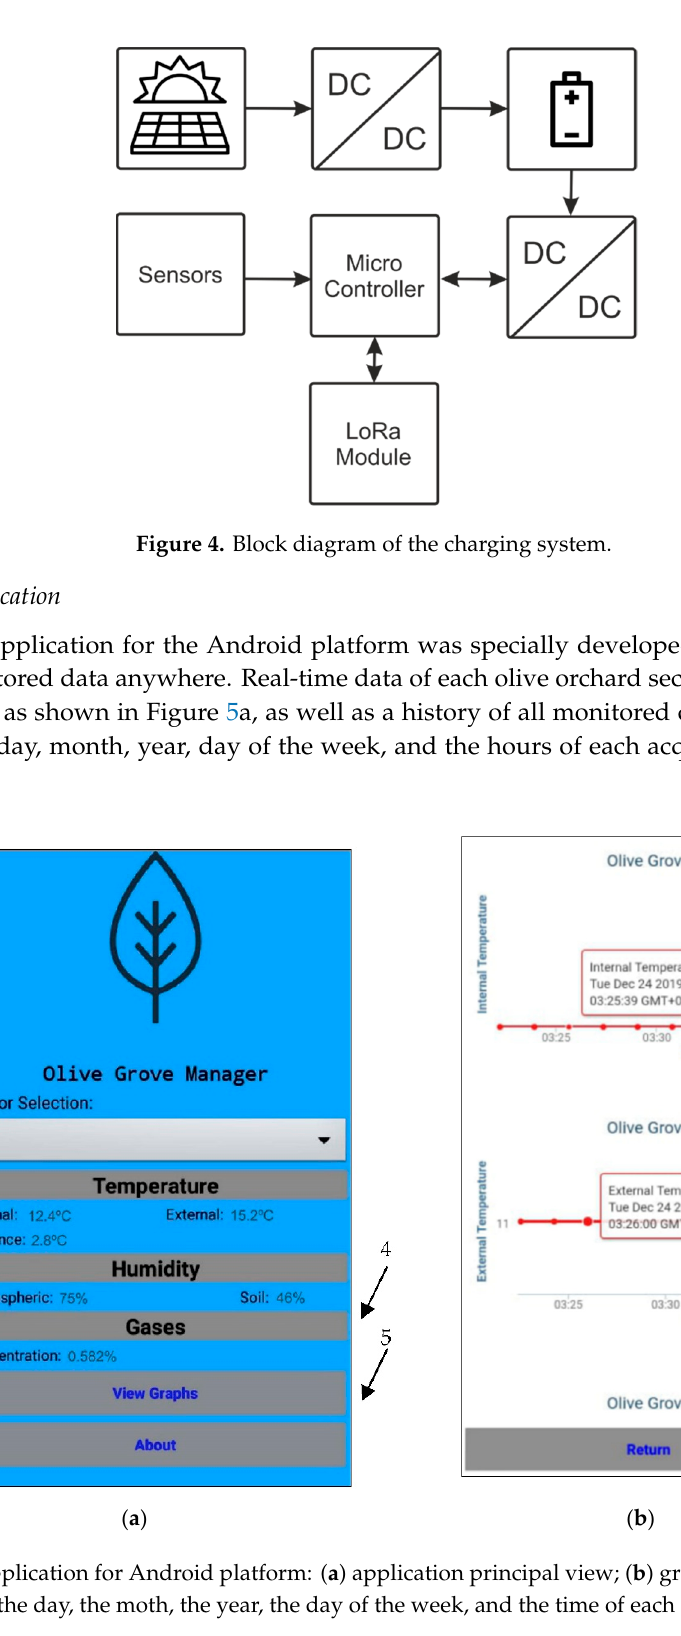
Figure 5. Application for Android platform: ( a ) application principal view; ( b ) graph with measured parameters, the day, the moth, the year, the day of the week, and the time of each acquisition.